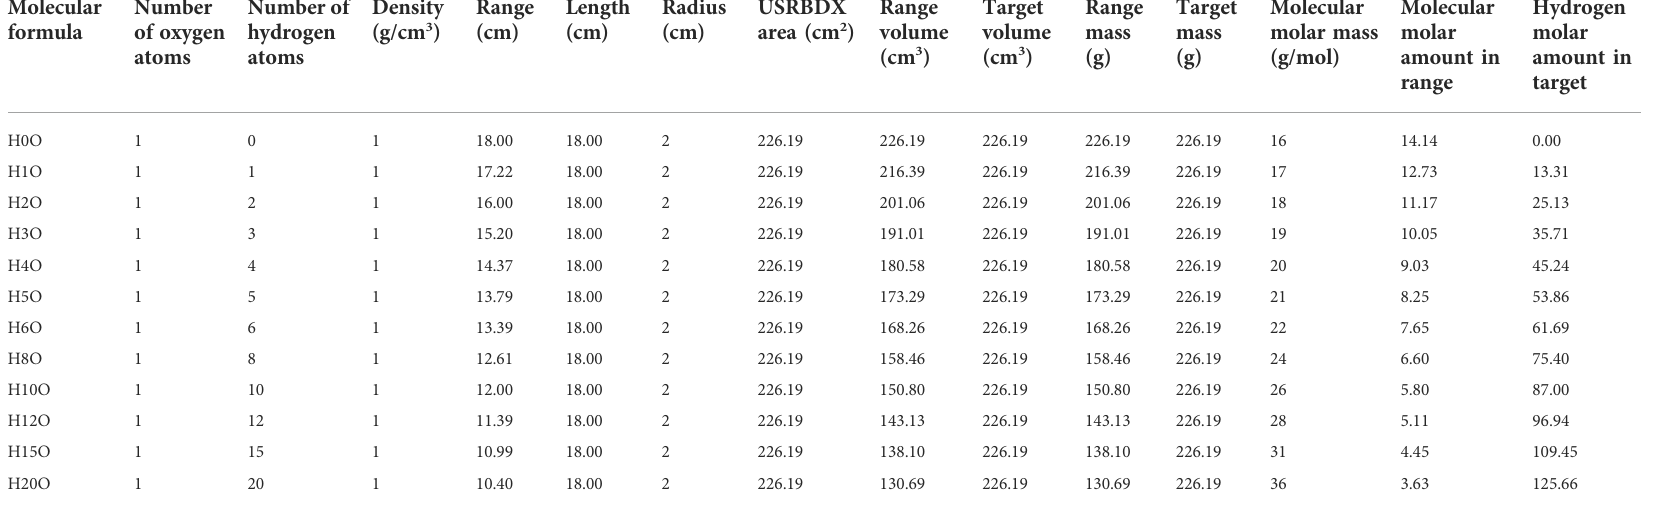
TABLE 2 Parameters for the MC simulation of combinations of oxygen and hydrogen.